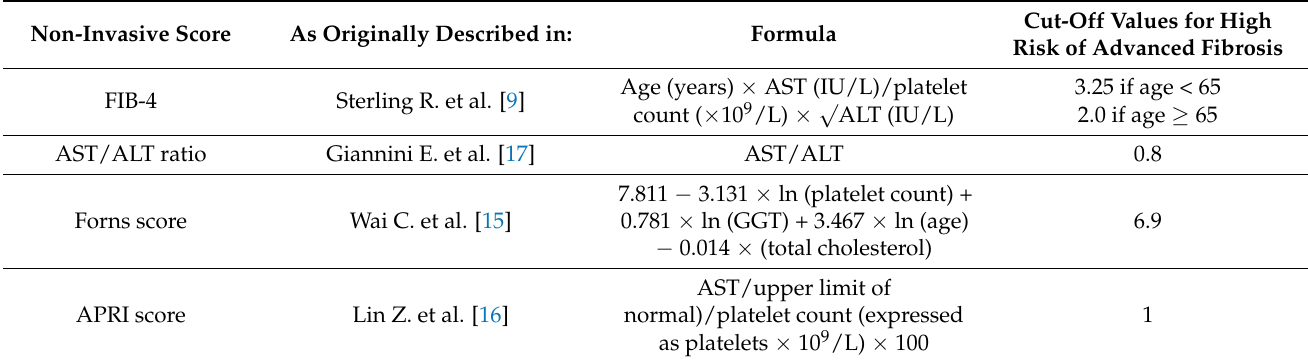
Table 1. Non-invasive fibrosis